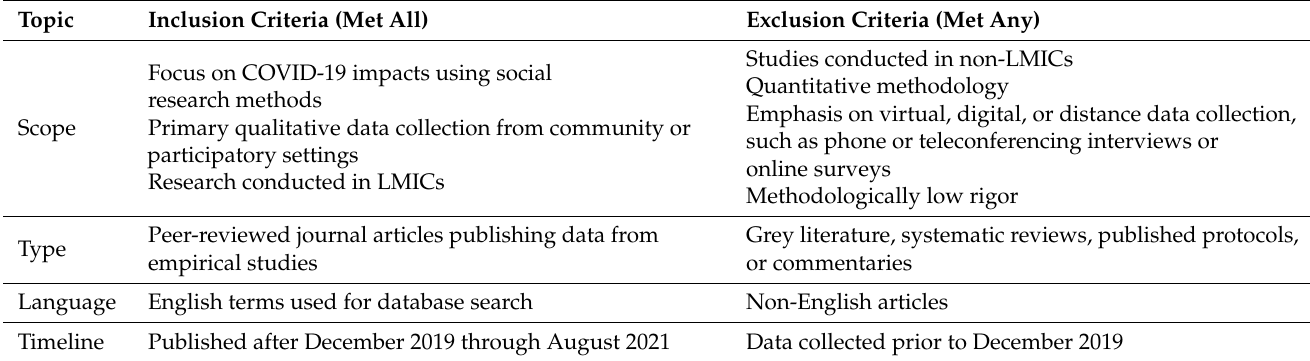
Table 1. Inclusion and exclusion